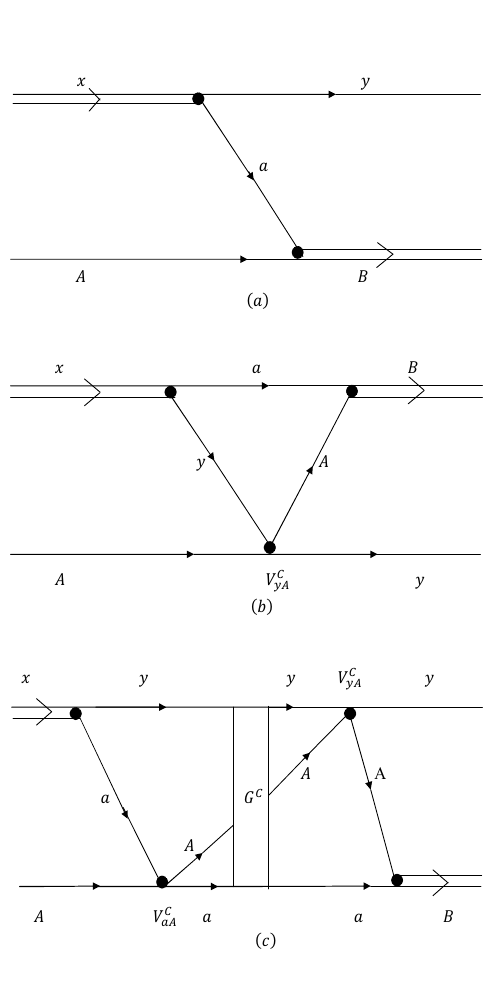
Figure 1. Diagrams describing transfer of a particle a and taking into account possible subsequent Coulomb rescattering of particles A , y and a in the intermediate